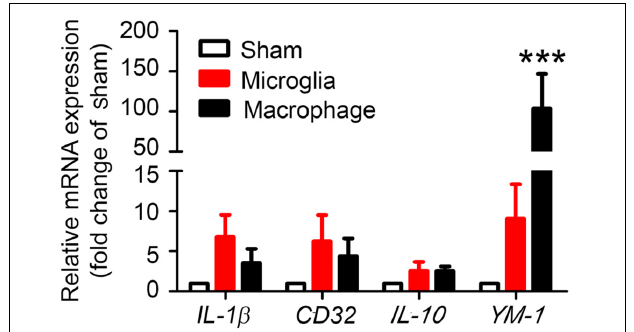
FIGURE 7 | Sorted microglia and monocytes/macrophages express M1 and M2 markers ex vivo . At 1 day after mice underwent collagenase injection or sham procedure, microglia (Ly6g − CD11b + CD45 Int PI − ) and monocytes/macrophages (Ly6g − CD11b + CD45 high PI − ) were isolated and sorted. mRNA from cells was extracted and real-time PCR carried out with different primers. GAPDH was used as an internal control, and results are shown as fold of sham. ∗∗∗ p < 0.001 vs. corresponding control; n = 3. Results are presented as mean ± SD. One-way ANOVA followed by Dunn’s multiple comparison